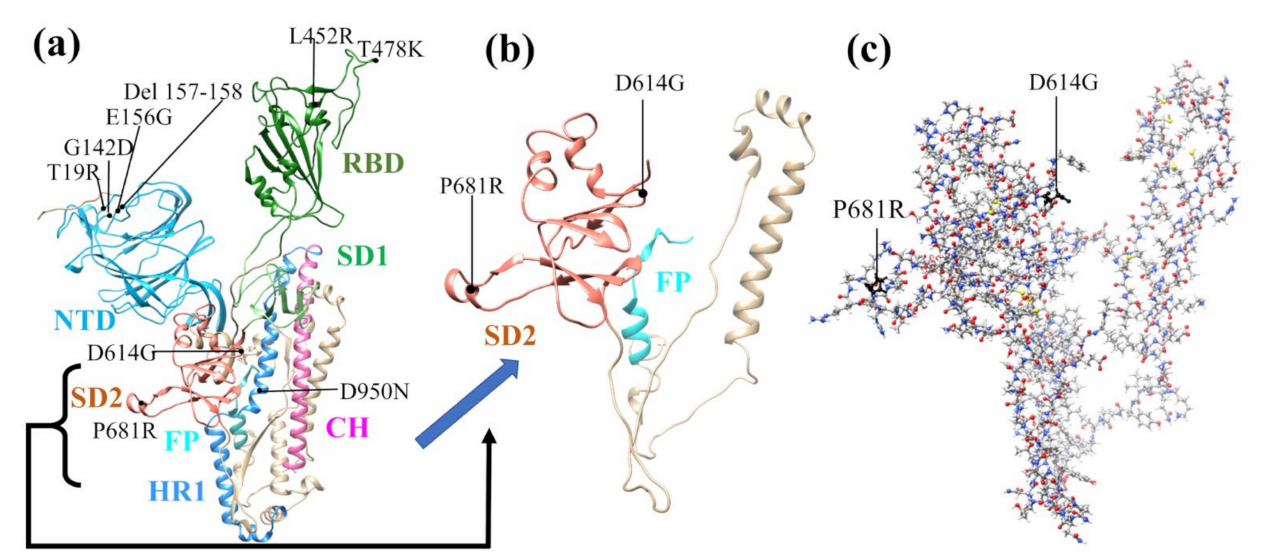
Figure 1. The illustration of SD2-FP model construction. ( a ) Ribbon of a single protomer in up conformation (chain A) of spike protein SARS-CoV-2 from signal peptide (SP) to central helix (CH) and the associated mutation for Delta variant in different domains, ( b ) the ribbon structure of SD1-FP model with two marked mutations that is selected for constructing our models, ( c ) ball and stick of the SD1-FP in ( b ) and their respective mutations as